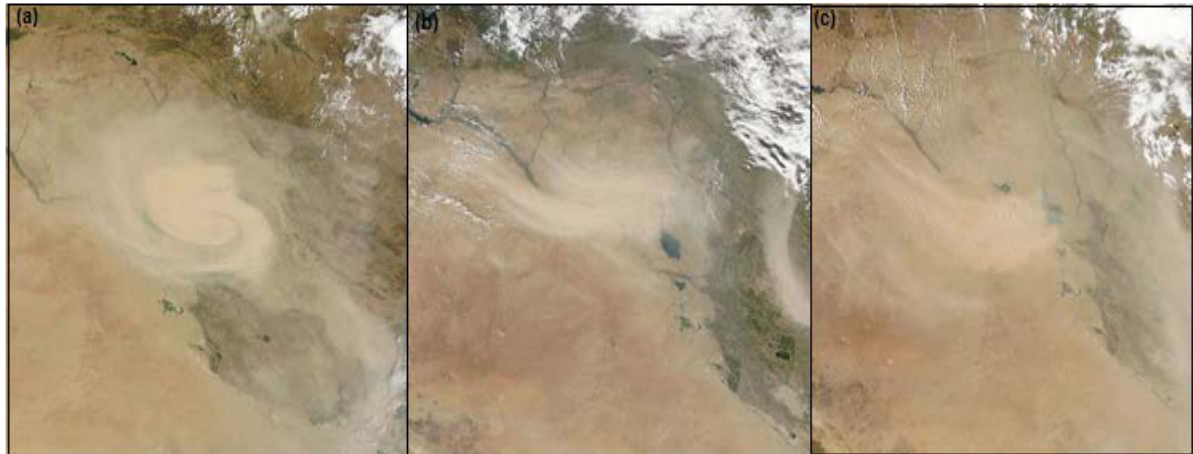
Fig.1: (a) MODIS terra true color (b1,b4,b3) 1/9/2015, (b) MODIS equa true color(b1, b4, b3) (c) MODIS terra true color (b1, b4, b3).